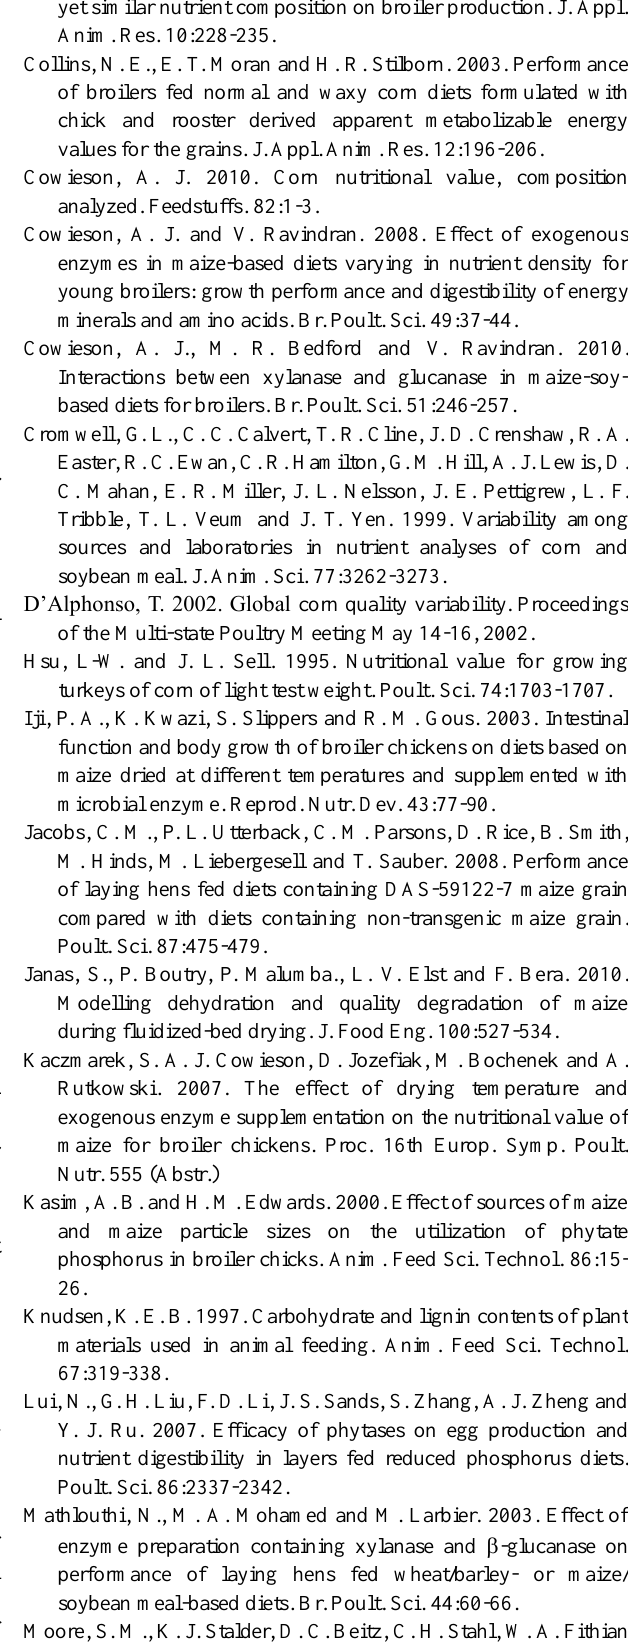
yellow dent corn hybrids having different kernel characteristics yet similar nutrient composition on broiler production. J.